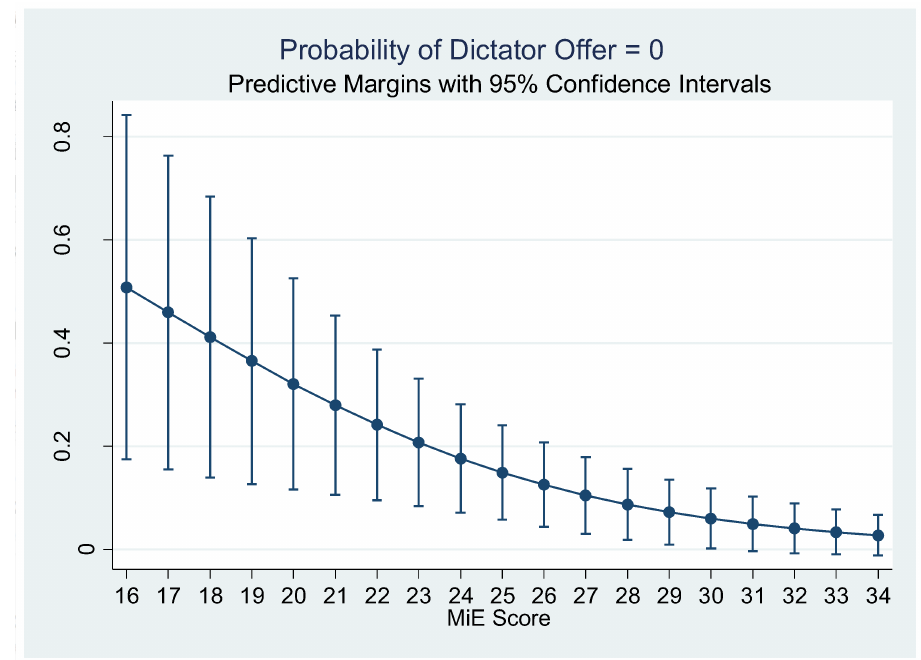
Figure 3. Predictive probability that dictator offer = 0 with MiE scores in the dictator game (Ordered Logit Model